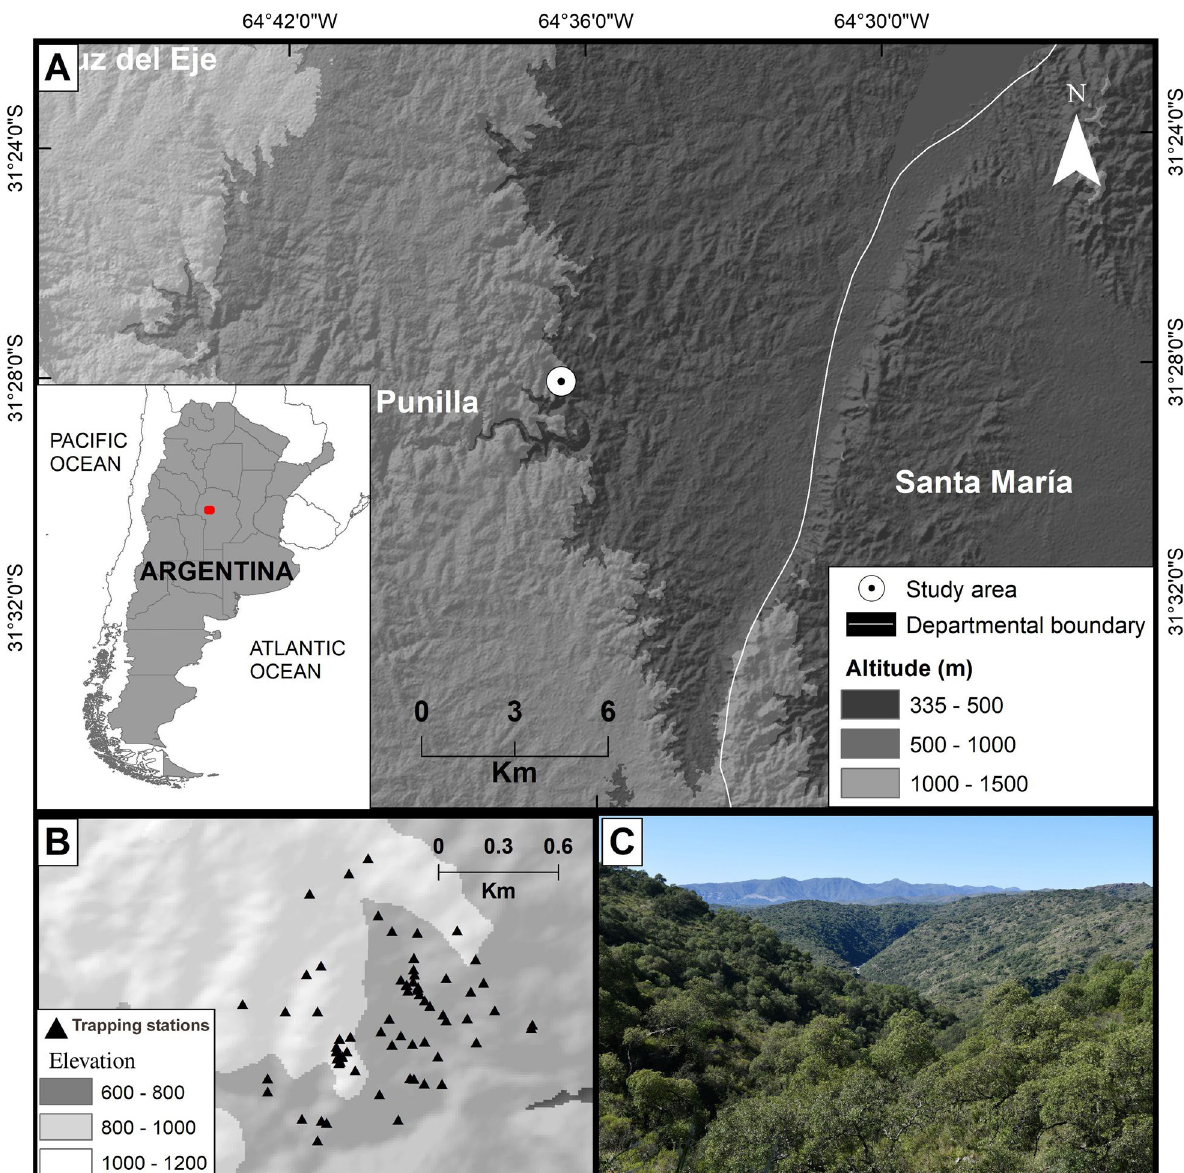
Fig. 1 A Map of the study area in central Argentina. B Distribution of the camera trap stations. C Photo of the mountain Chaco forests, where the surveys were